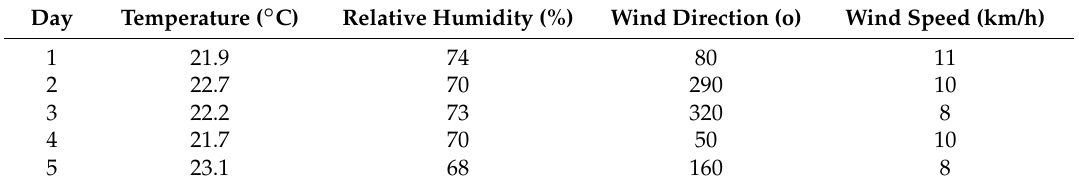
Table 4. Average meteorological conditions between 7 AM and 9 AM for the five study